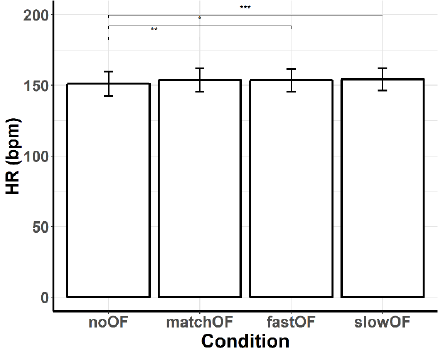
Figure 6. Mean heart rate. The bars represent the means and the error bars the 95% confidence interval of those means.